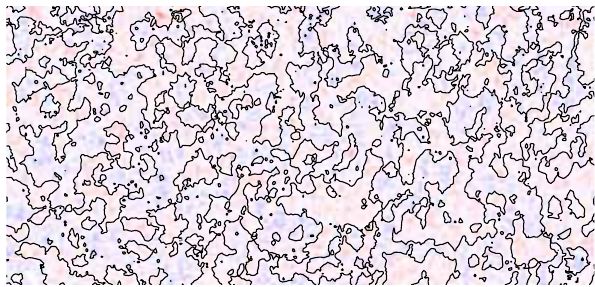
Fig. 5. QS raster in Si II 1533, obtained on 7 November 1999. The FOV is 633 00 × 300 00 . Brightness contours, which are overlaid on shifts nicely outline the redshift/blueshift